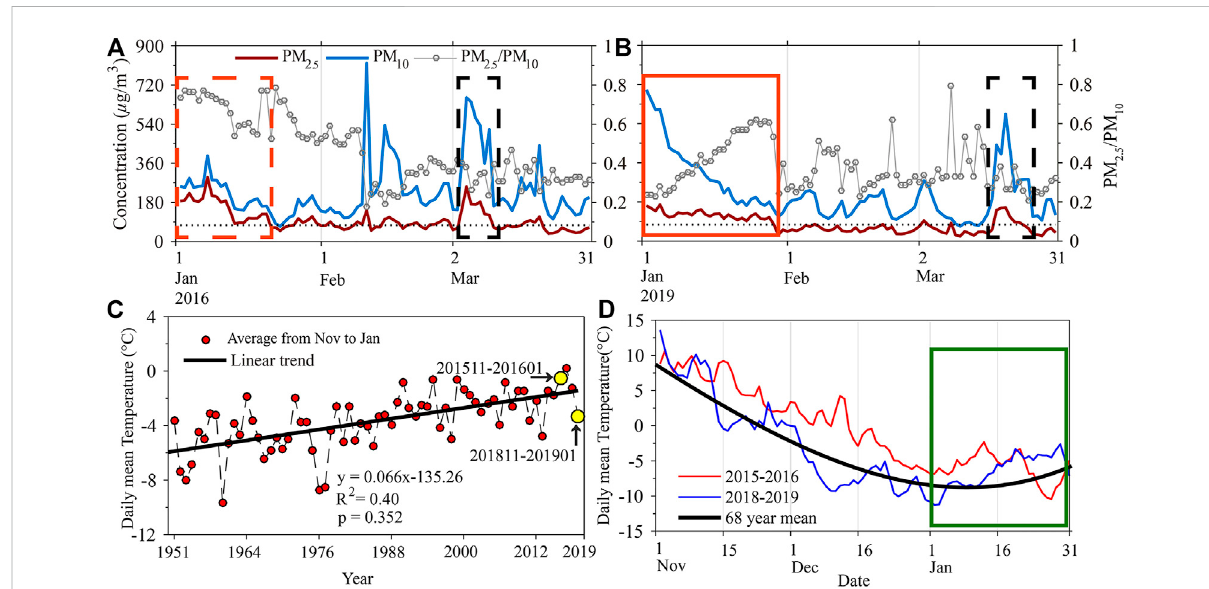
FIGURE 9 Variations ofdaily meanconcentrationsofPM 2.5 (brown line),PM 10 (blueline)andtheratioofPM 2.5 to PM 10 (gray circle)inTurpanfromJanuary toMarchin (A) 2016 and (B) 2019. (C) Thevariation ofaveragetemperature(redcircle)anditslineartrend(blackline)inwinter(NovembertoJanuary of the next year) in Turpan from 1951 to 2019. (D) The variation of daily temperature in winter of 2015 (red line), 2018 (blue line) and 68-years mean from 1951 to 2019 (black line). The dotted lines in (A) and (B) represent the concentration level of 75 μ g · m − 3 , which is the threshold for